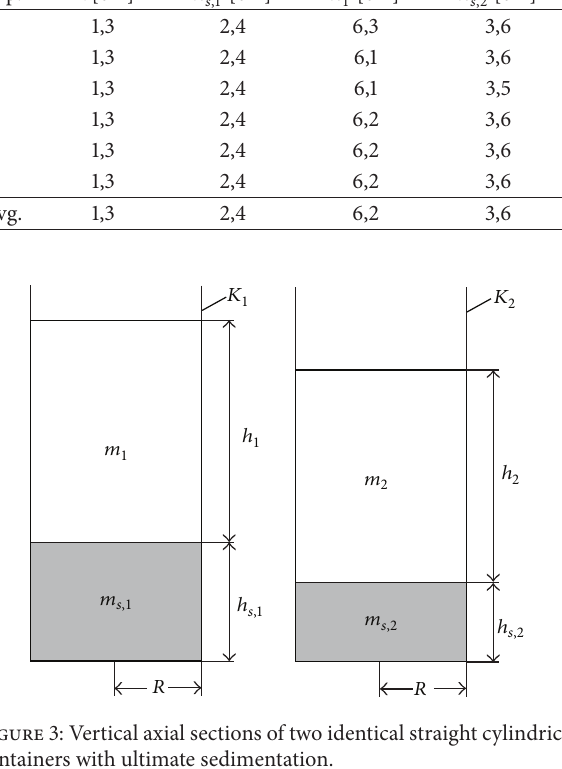
Table 1: Linear dimensions, masses, and densities of the components of liquid dispersions. Exp.